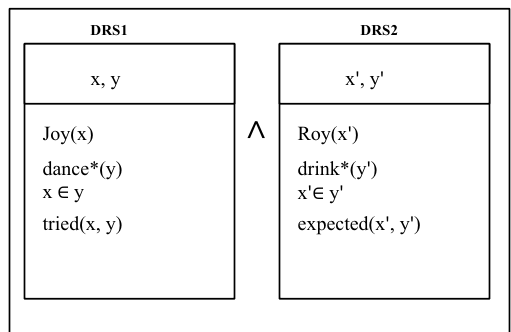
Figure 8: A DRS for the sentence ‘ Joy tried to dance and Roy expected to drink ’